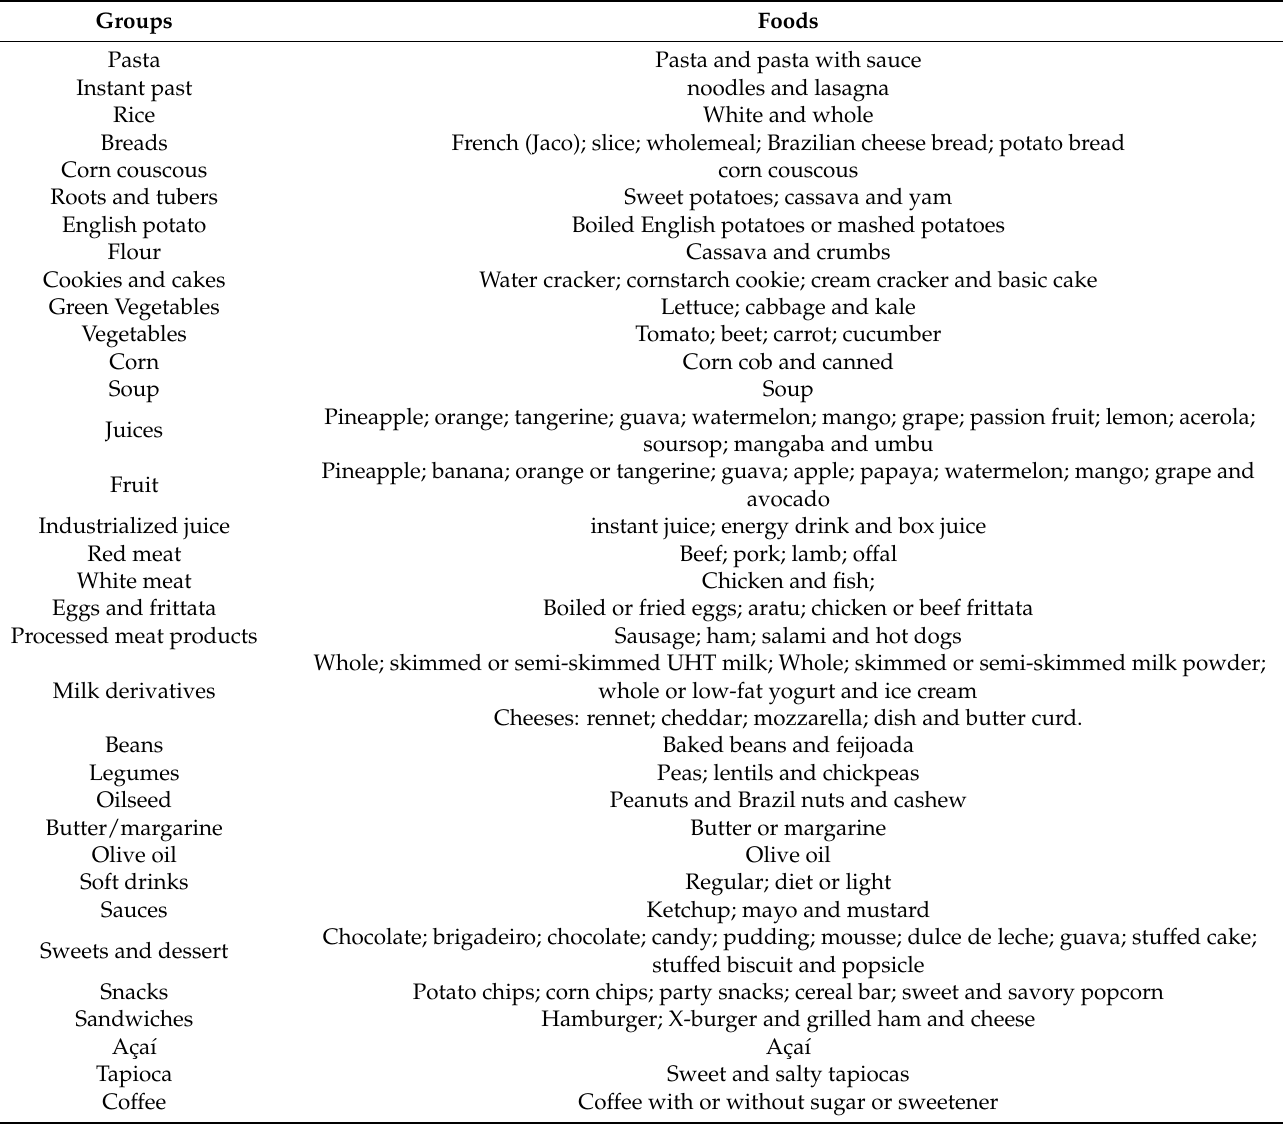
Table 1. Grouping of foods according to nutritional value for analysis of dietary